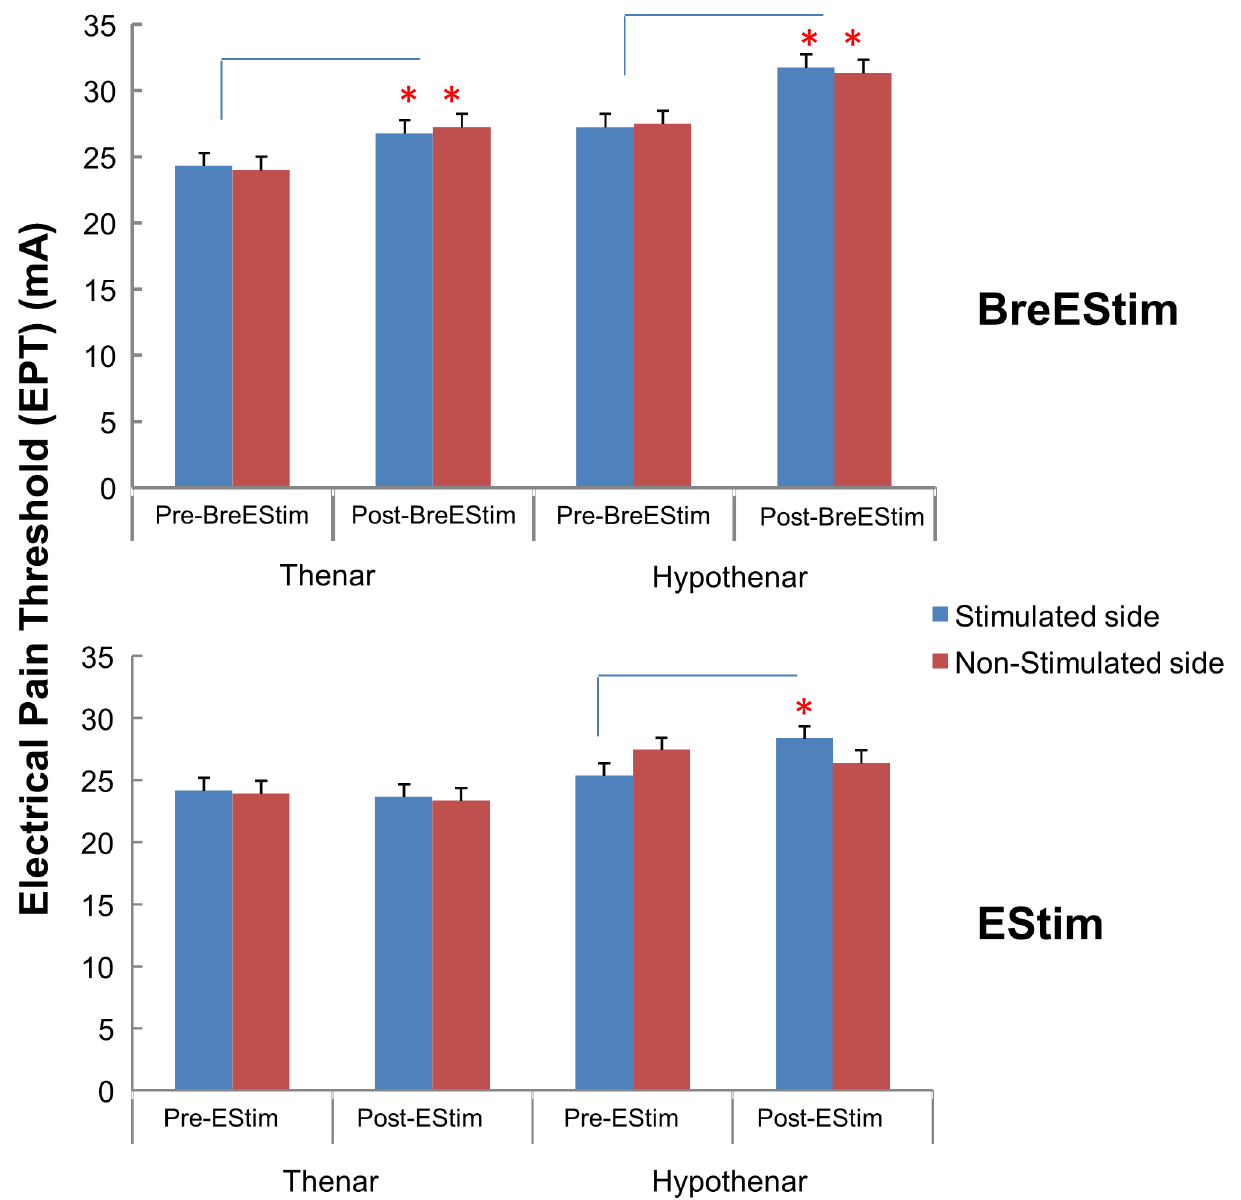
Figure 2. Electrical pain thresholds pre- and post-BreEStim (upper panel) and pre- and post-EStim (lower panel) in all four tested sites on both stimulated and non-stimulated side. Average values and standard errors are shown.